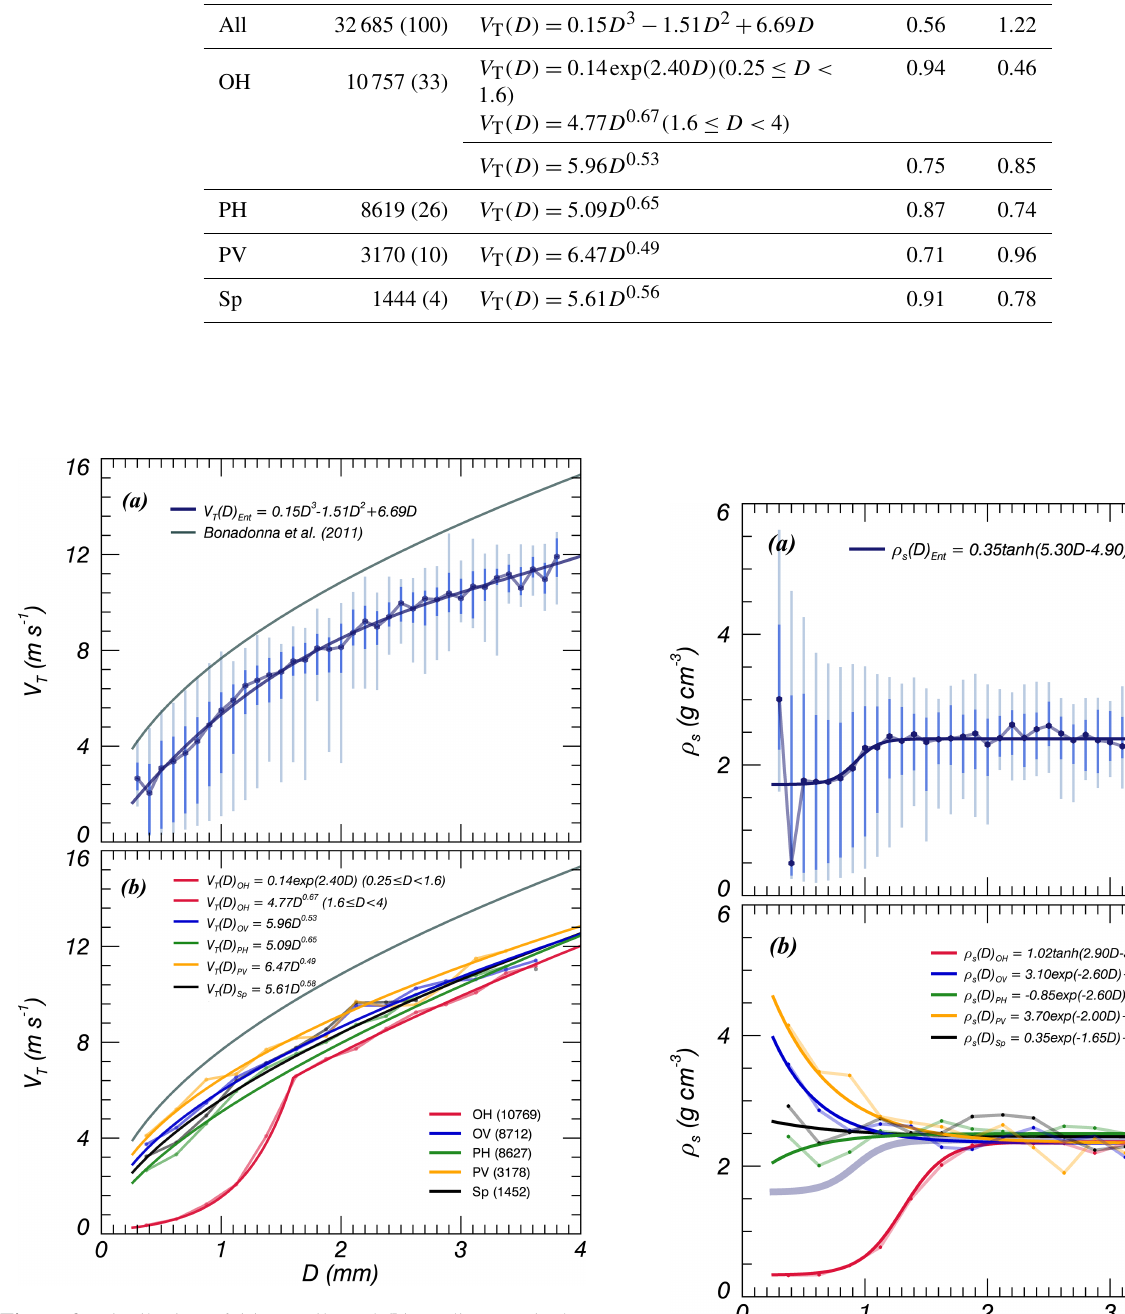
Figure 9. Distribution of (a) quartile and (b) median terminal ve- locity ( V T ) values after applying the 60% V T QC threshold for all shape types and each individual particle shape type, respectively. The solid grey line shows the relationships of the volcanic ash par- ticles suggested by Bonadonna et al. (2011).